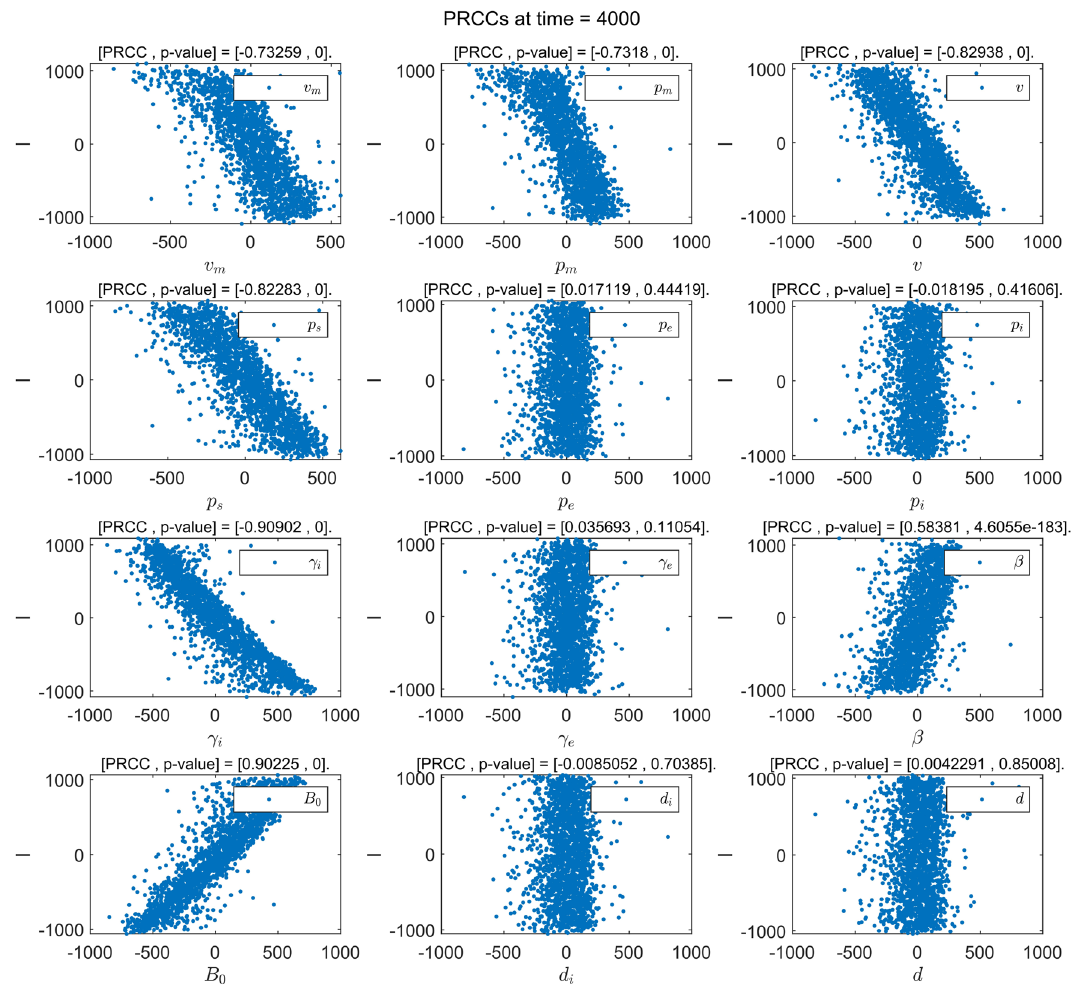
Figure 5. Scatter plot of PRCC value for each parameter in I ( t ).